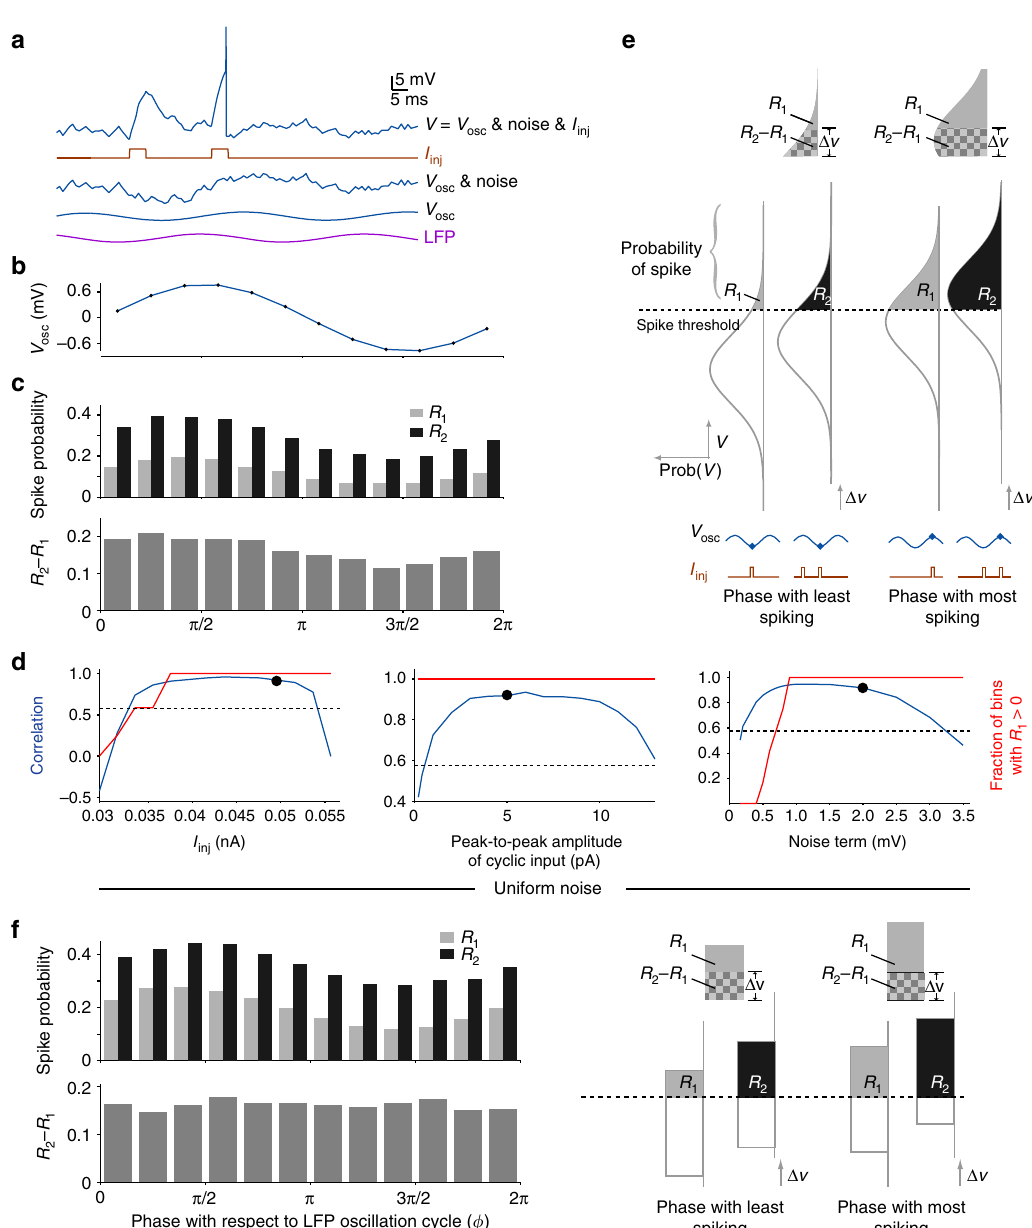
Figure 3 | Computational model shows noise contributes to phase-dependent summation. ( a ) Top: representative membrane potential trace from a model KC. The membrane potential ( V ) has three independent components: subthreshold oscillations ( V osc ) generated by the integration of oscillatory input from PNs; noise and a pair of current pulses ( I inj ) injected into the cell. In this example, the second current pulse elicited a spike. Oscillations in both LFP and V osc are caused by the same oscillatory input from PNs, but are delayed in V osc (see Methods). ( b ) The model’s average membrane potential as a function of the LFP phase ( f ). ( c ) R 1 ( f ) and R 2 ( f ) show a phase-dependency similar to V osc . The effect of summation, R 2 ( f ) (cid:2) R 1 ( f ), also shows a similar phase-dependency. ( d ) Blue lines: correlation between R 2 – R 1 and subthreshold oscillations was robust to variations in model parameters, such as the amplitude of the injected current pulses ( I inj ), the amplitude of the subthreshold oscillations, and the amplitude of noise. Dots: parameter values used in simulations shown in a - c . Dashed line: correlations larger than this value (0.576) are statistically significant ( P o 0.05). Red line: fraction of phase bins (of 12) in which R 1 ( f ) 4 0. ( e ) A graphical description of phase-dependent summation in the presence of noise. The membrane potential oscillates ( V osc ) when given cyclic input. Noise causes the actual voltage V at a given phase to vary from the mean. The probability distribution of V at any phase must be approximately Gaussian because of the accumulation of noise. The area of this distribution above the spiking threshold equals the probability of spiking at that phase. If the cell receives two current pulses, the distribution of V during the second pulse shifts upward by D V relative to the distribution of V during the first pulse. At the phase where V osc is lowest (left), shifting the distribution by D V produces a small change in area above the curve ( R 2 (cid:2) R 1 , shown in checkerboard pattern). At the phase where V osc is highest (right), the same shift D V produces a larger change in the area (compare the two checkerboard areas). Thus, owing to the nonlinear shape of the noise distribution, the first pulse makes a larger contribution to the second pulse when the second pulse occurs at phases close to the peak of V osc . ( f ) If the noise distribution is made uniform (see Methods), R 2 (cid:2) R 1 loses its phase-dependence and correlation with subthreshold